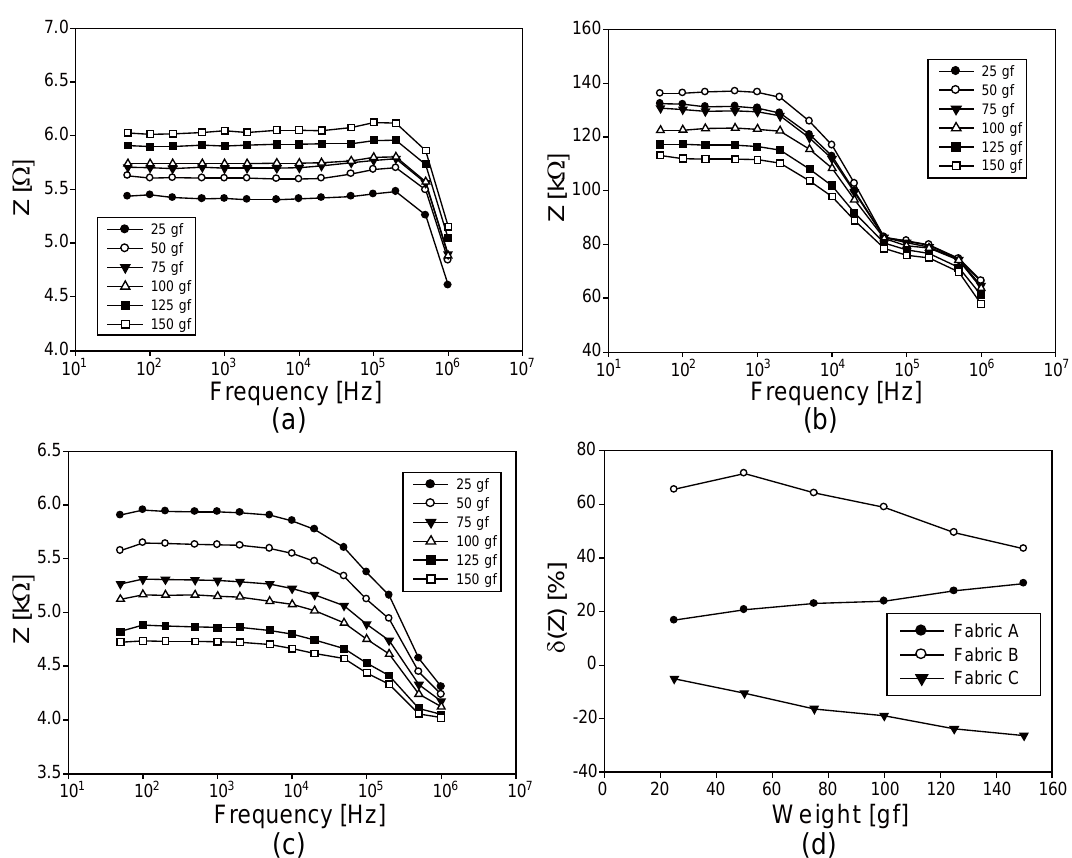
Figure 9. Impedance magnitude spectra of three conductive fabrics under tension. ( a ), ( b ), and ( c ) are from the fabrics A, B, and C, respectively; ( d ) shows the plots of the impedance magnitude changes at 10